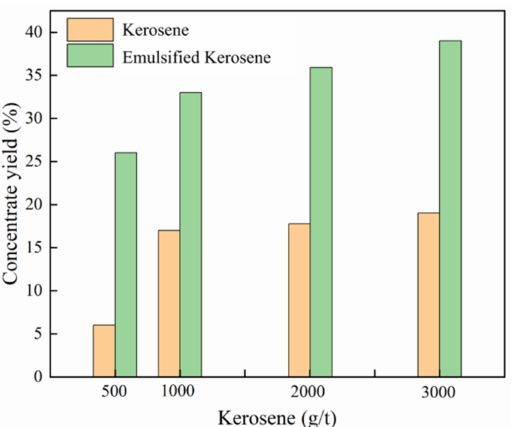
Figure 6. Comparisons of flotation yields of oxidized coal (12 h oxidation time) between kerosene and emulsified kerosene under various flotation reagent dosages. For conventional conditions, the weight ratio of kerosene and sec-Octyl alcohol was 3:1. For the mixture reagent (emulsified kerosene), the equivalent kerosene dosage was also kept as 500 g/t as a control test.